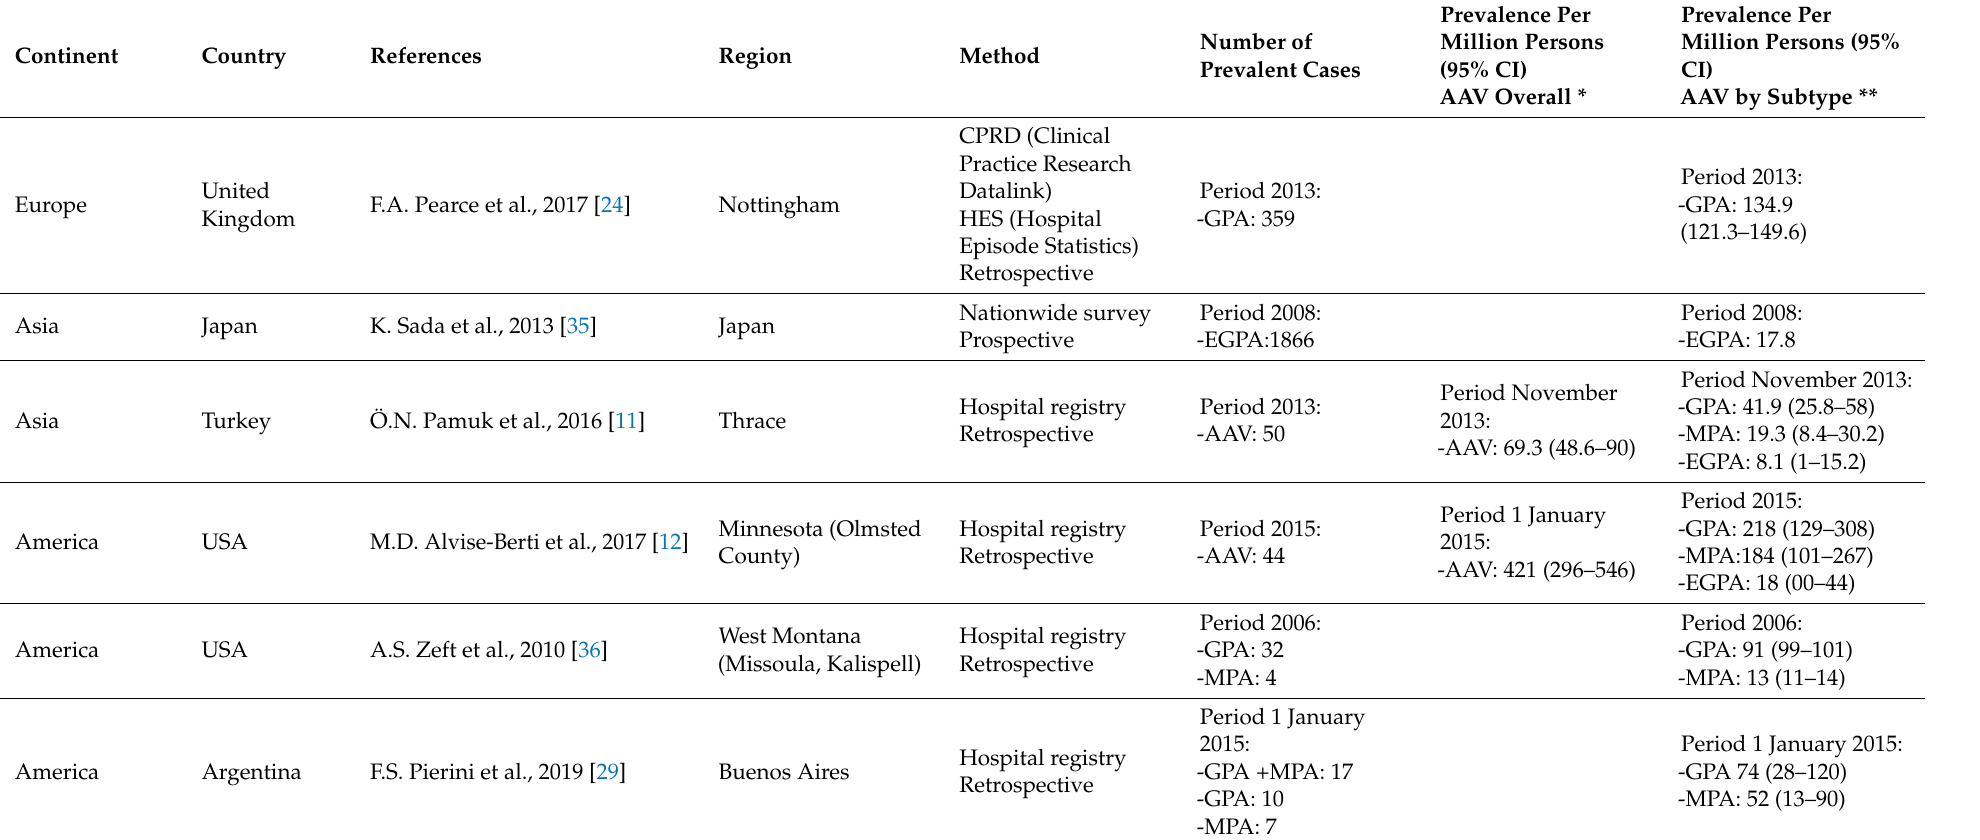
Table 6. Worldwide prevalence of